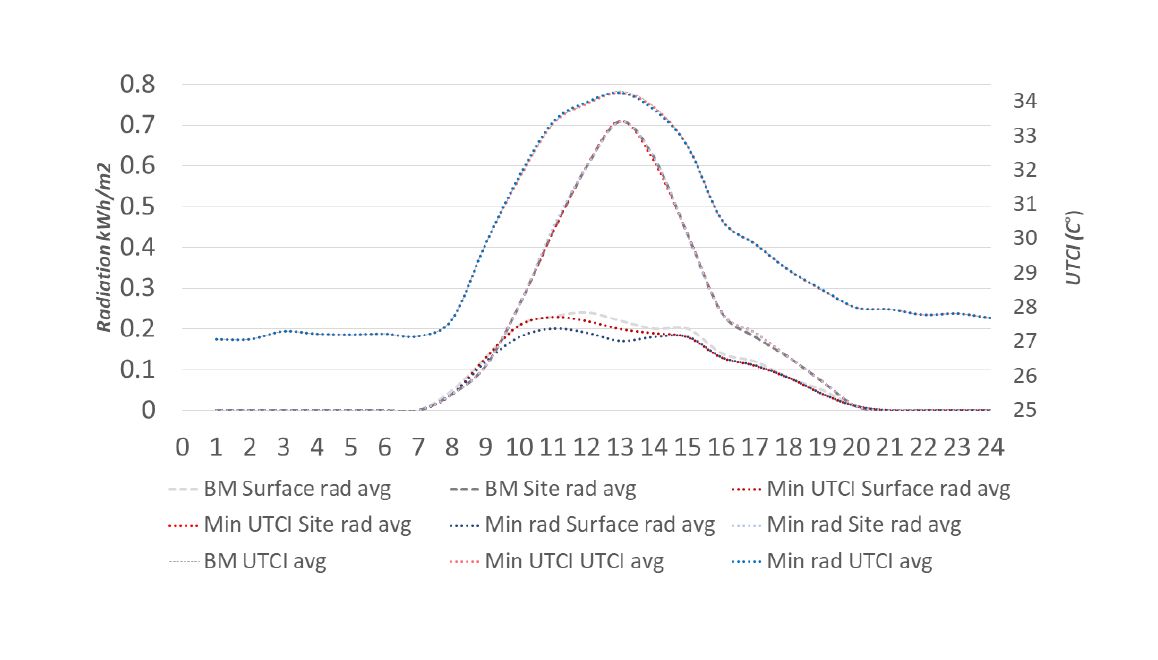
Fig. 11. Monthly utility costs for minimum UTCI model, Aug 8.